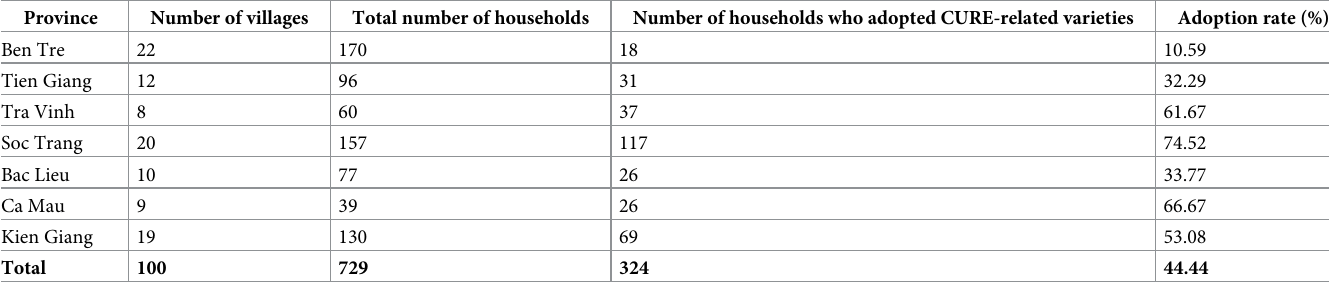
Table 2. Adoption rate of CURE-related varieties by